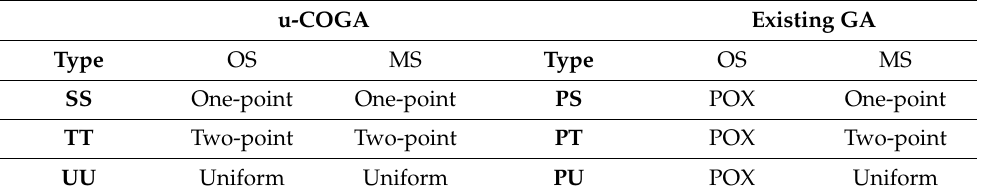
Table 5. Types of crossover operators applied to the existing GA and